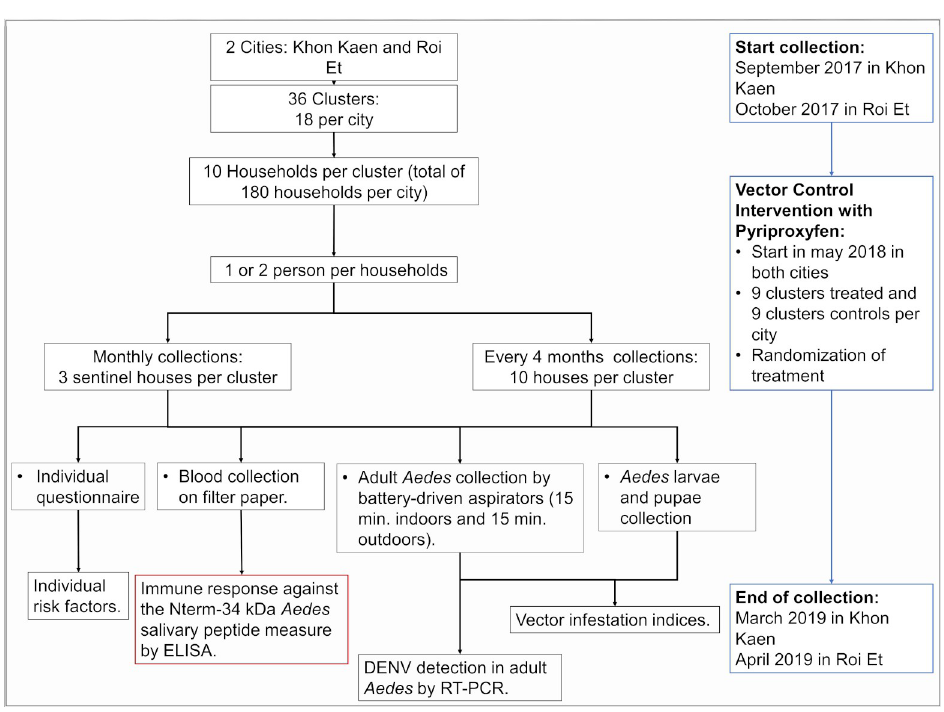
Fig 2. Study design flow chart. RT-PCR: Reverse Transcriptase Polymerase Chain